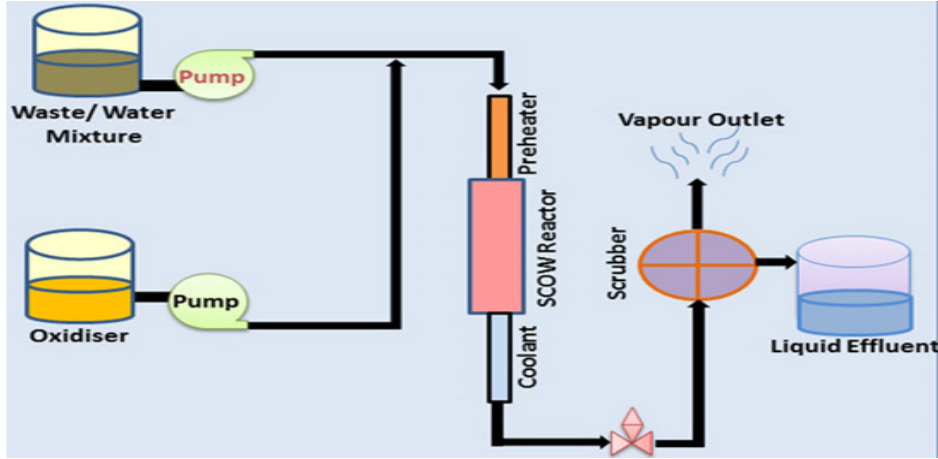
Figure 2. Advance oxidation process in wastewater treatment by a Scow reactor